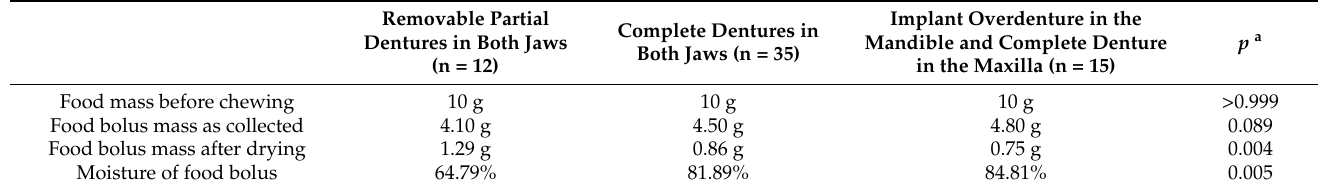
Table 3. Median of mass and moisture of food bolus collected from patients with removable prosthe- ses rehabilitations that were most frequently encountered in this